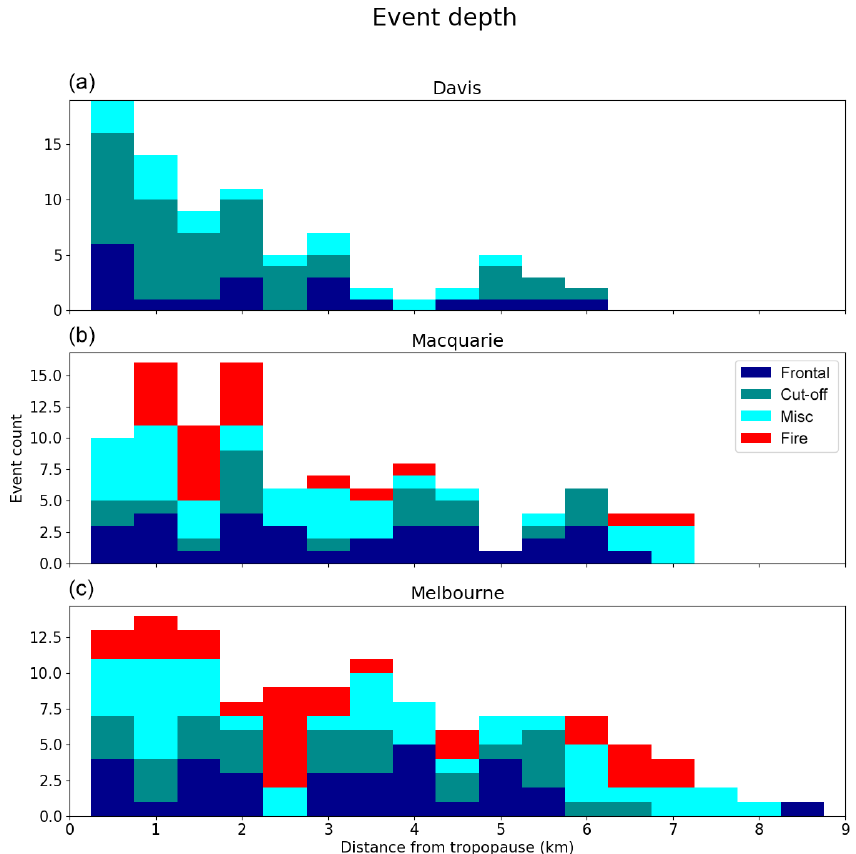
Figure 8. The distribution of STT events’ depths, defined as the distance from the event to the tropopause, at Davis (a) , Macquarie Island (b) , and Melbourne (c) , determined as described in the text. Events are coloured as described in Fig. 5.